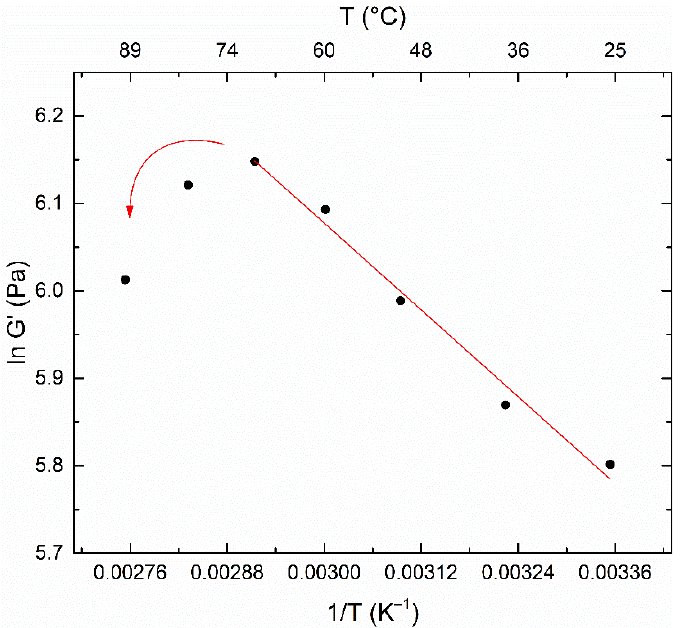
Figure 7. Arrhenius plot of the logarithm of the storage modulus vs. temperature. All experimental parameters as specified in Figure 6.